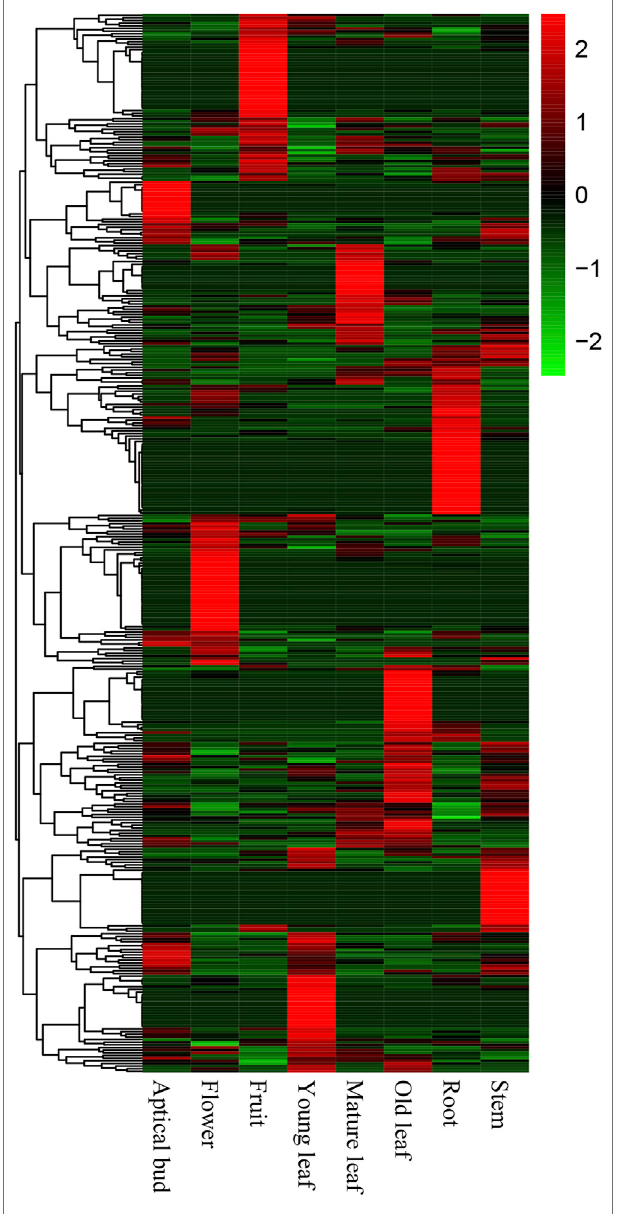
FIGURE 6 | Expression pattern of Camellia -speci fi c genes (CSGs) in different tissues includes apical bud, young leaf, mature leaf, old leaf, stem, fl ower, fruit, and root.